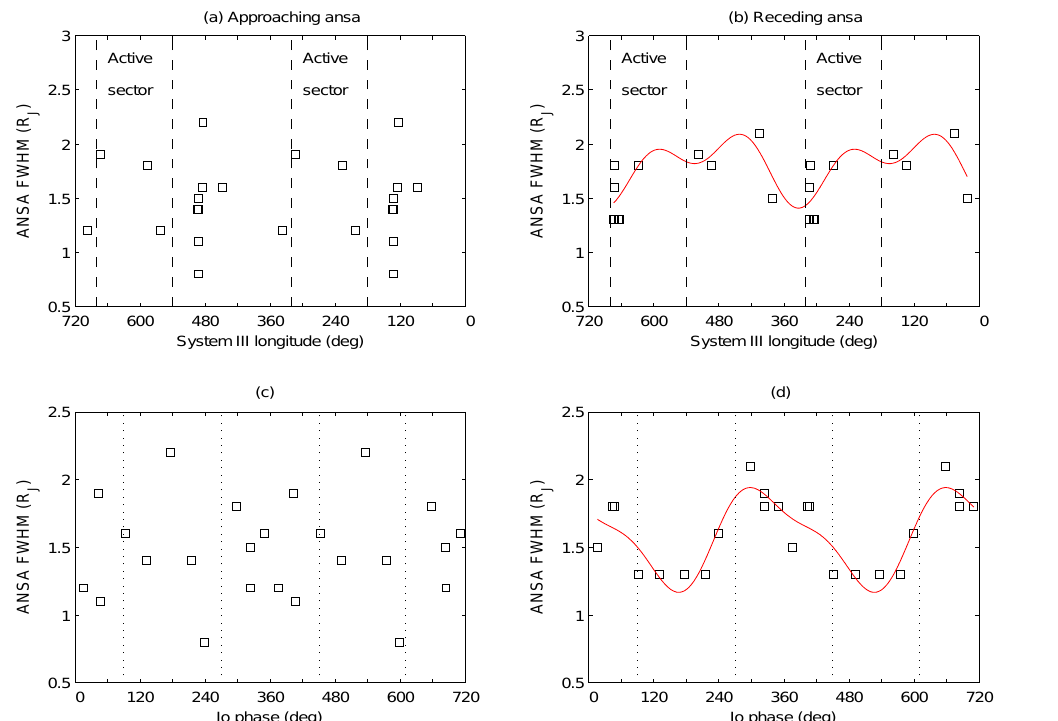
Figure 5. The FWHM of the ansae as a function of system III longitude (a, b) and Io phase angle (c, d) . The red lines are second order Fourier fits to the data.